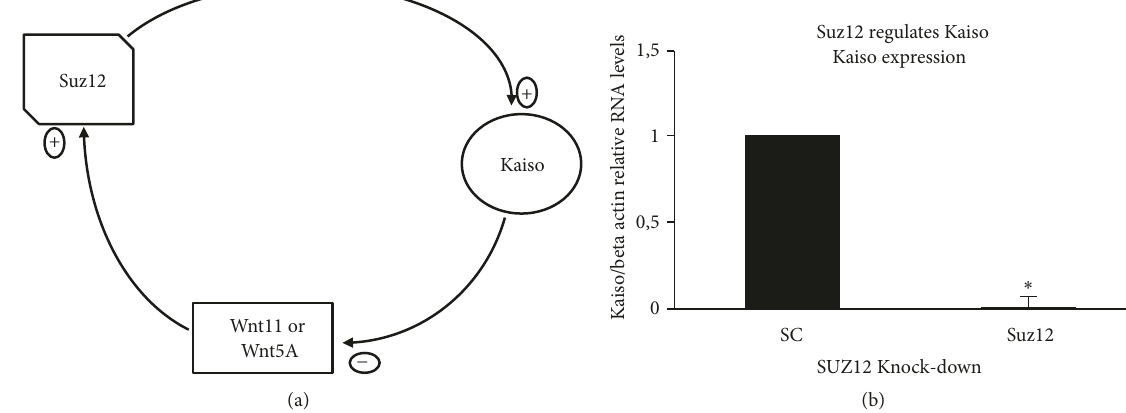
Figure 3: Regulatory loop among Kaiso, Wnt11/5a and Suz12. (a) The genes Wnt11 and Wnt5a upregulate Suz12 expression (suppressor of zeste 12) acting in the nucleus as transcriptional factors. Kaiso and TCF/LEF cooperate to repress the transcription of Wnt11 and Suz12 activate the transcription of Kaiso. This regulatory loop proposed could be reinforced by other nonclassical-Pc-functions as, for example: (i) EZH2 physically interacts directly with 𝛽 -catenin, functionally improves the Wnt target gene expression and phenotypically leads to the overexpression of c-Myc and cyclin D1 [54, 55], (ii) BMI1 might also act as an activator of WNT pathway by repressing Dickkopf (DKK), and its negative regulation results in upregulation of c-Myc that participate in a positive feedback loop, activating the transcription of BMI1 [56], and (iii) the overexpression of WNT/ 𝛽 -cateninsignaling can also lead to increase Wnt11 expression [58–60]. (b) Expression analysis of Kaiso in Suz12 knockdown cells. K562 cells were transfected with siRNA-Suz12 (25nM). Twenty-four hours later, RNA was isolated and subjected to Real Time RT-PCR to quantify expression of Kaiso after normalization to 𝛽 -actin and compared to the scrambled knockdown cells. Data were expressed as mean ± standard deviation (SD). Columns, mean (n= 3); error bars, SD; ∗ p <